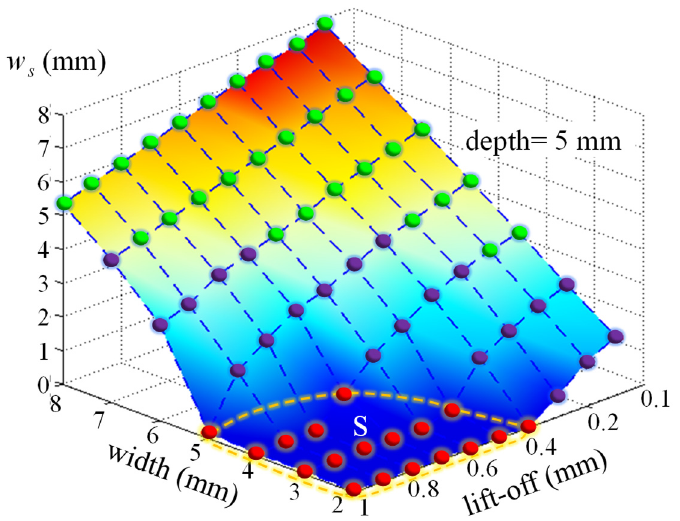
Figure 10. Values of w s (depth value = 5 mm).